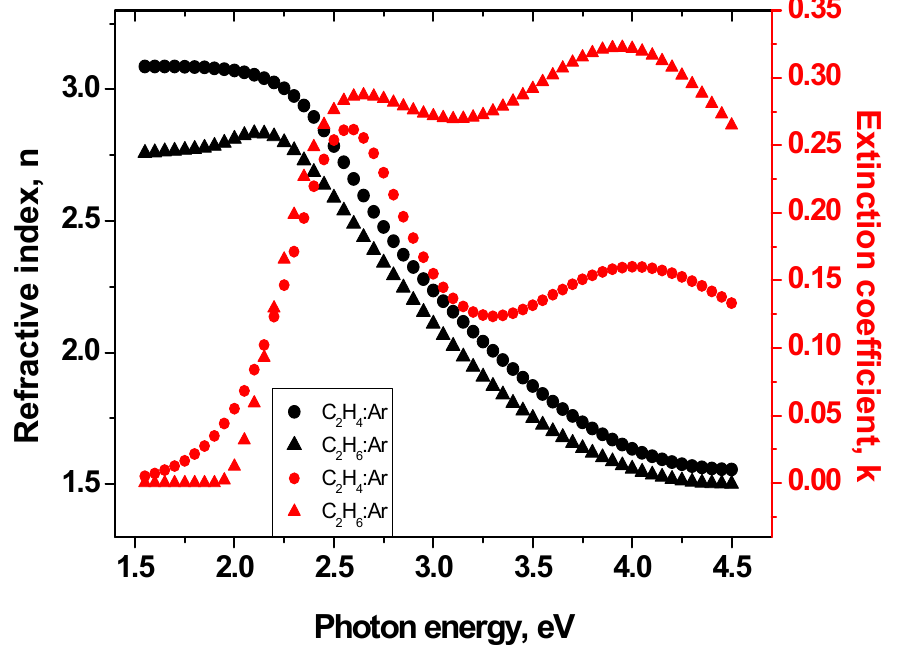
Figure 4. Wavelength-dependence of the optical constants n ( λ ) and k ( λ ) for the films prepared with C 2 H 4 /Ar and C 2 H 6 /Ar gas mixtures.